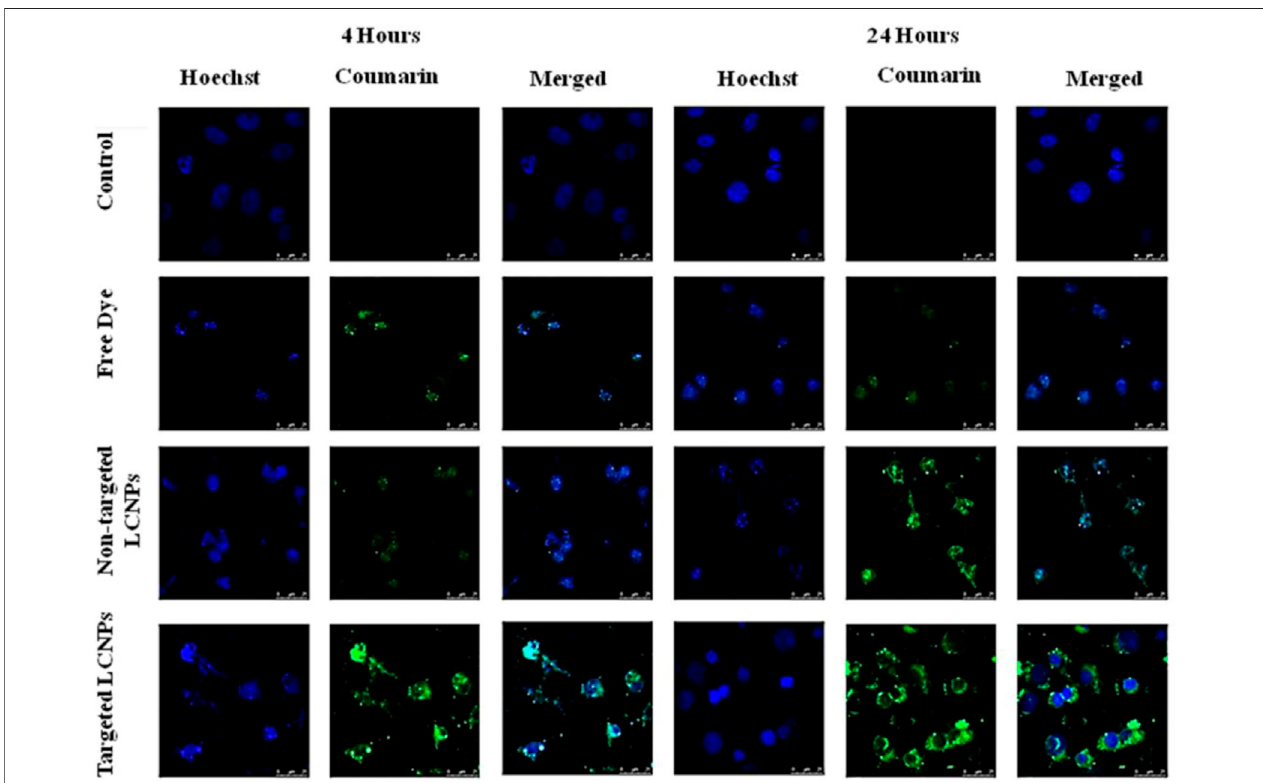
FIGURE 7 | Confocal images showing cellular uptake of free coumarin dye, non-targeted coumarin-labeled LCNPs, and Lf-targeted coumarin-labeled LCNPs within MCF-7 breast cancer cells after incubation for 4 and 24 h.